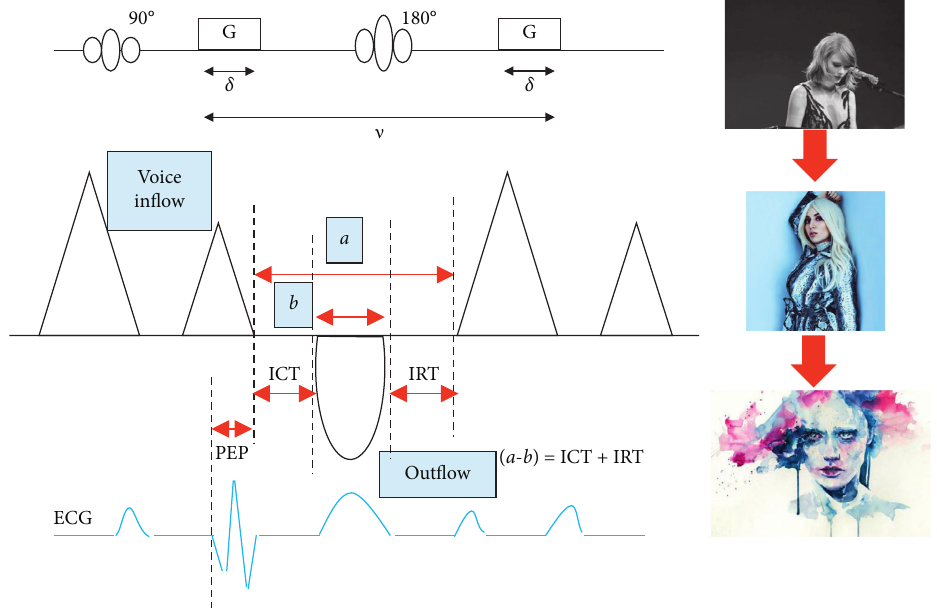
Figure 2: System functional structure